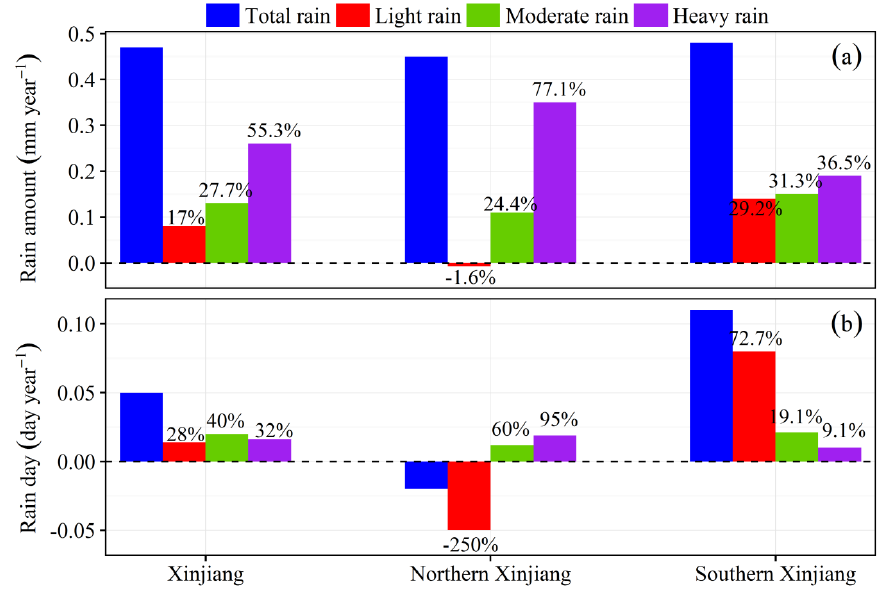
Figure 4. The proportions of light, moderate, and heavy rain contributing to changes in rain amounts and days during the warm season from 1960–2014. ( a ) Rain amounts; and ( b ) rain